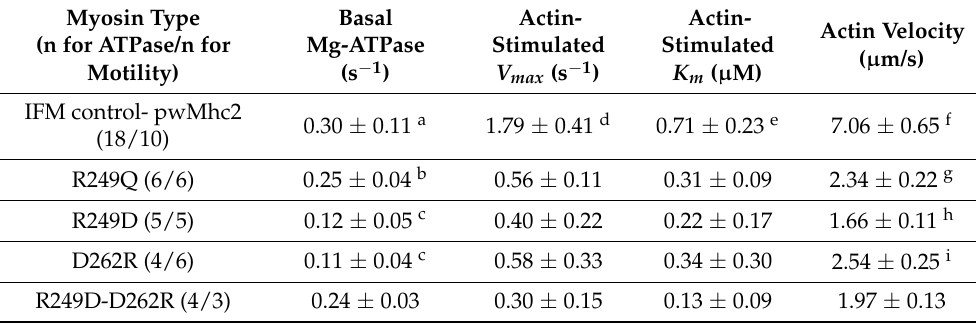
Table 3. ATPase activities and in vitro motility velocities of wild-type and mutant